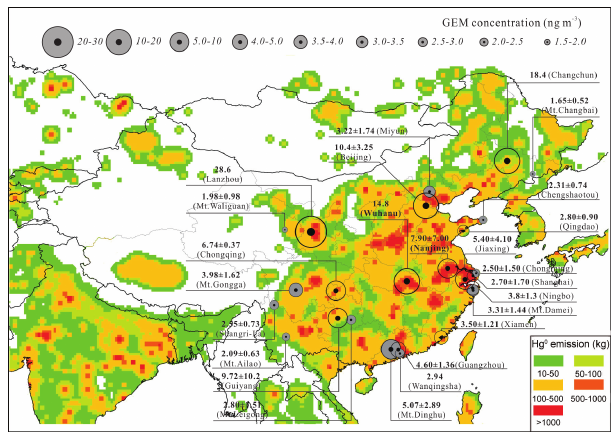
Figure 1. A map showing the locations and atmospheric GEM con- centrations observed at ground-based sites in China (gray circles and hollow circles indicate remote and urban sites, respectively. GEM concentrations are indicated by the size of the circles. Data sets were from literatures in Table 1) and 0.5 ◦ × 0.5 ◦ gridded an- thropogenic Hg 0 emissions in Asia (AMAP/UNEP,